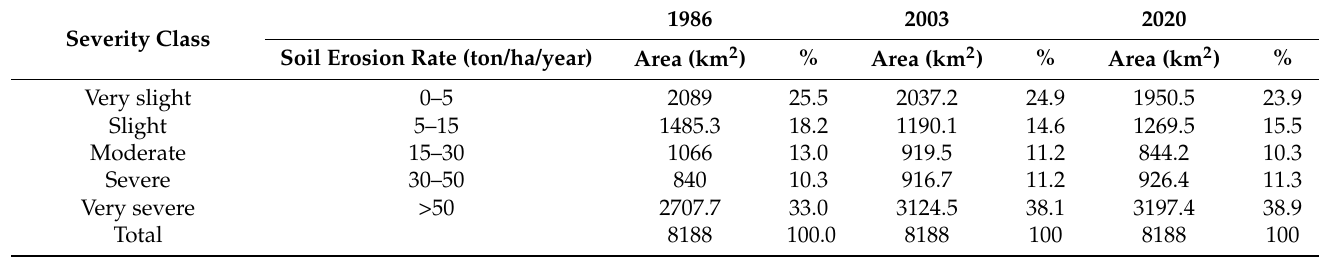
Table 7. Erosion severity classes and area of soil loss in the Muger Sub-basin.